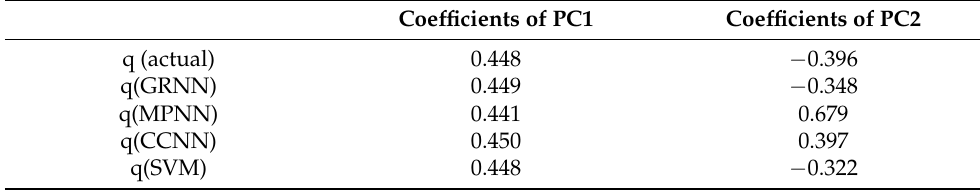
Table 7. Extracted eigenvectors for actual wave-overtopping discharge and ANN and SVM